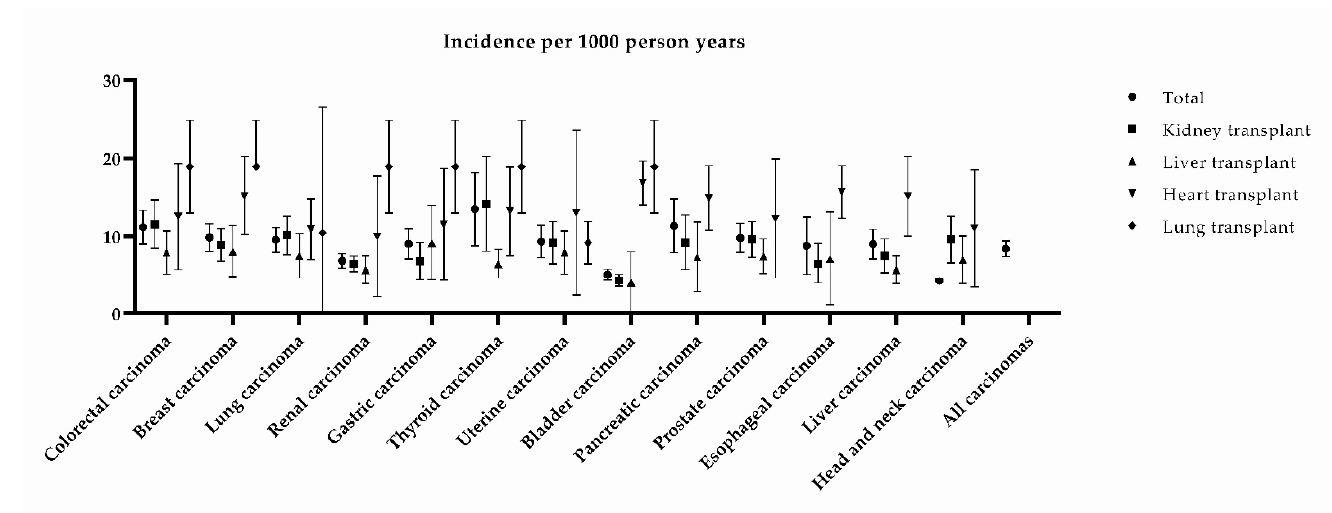
Figure 2. Pooled mean incidence of de novo carcinomas per 1000 person-years. Bars denote the 95% confidence interval.